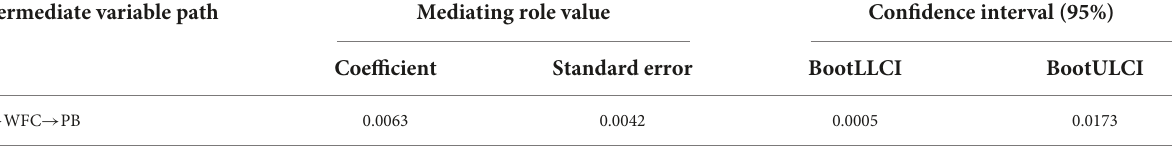
TABLE 5 Test results of the mediation effect of work-family conflict ( n = 555).